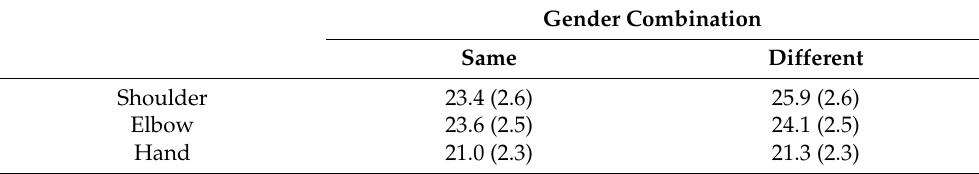
Table 1. Average (S.E.) of minimum comfortable distance in centimeters by gender combinations and body parts.